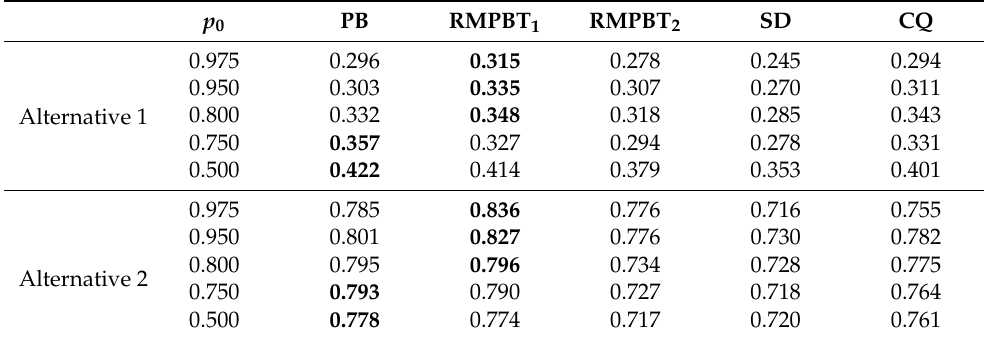
Table 4. Power analysis of 4 tests assuming the true covariance matrix is Σ = Σ 3 ; n 1 = n 2 = 70 and p = 1000. RMPBT is the approach of [12], SD is the approach of [4] and CQ is the approach of